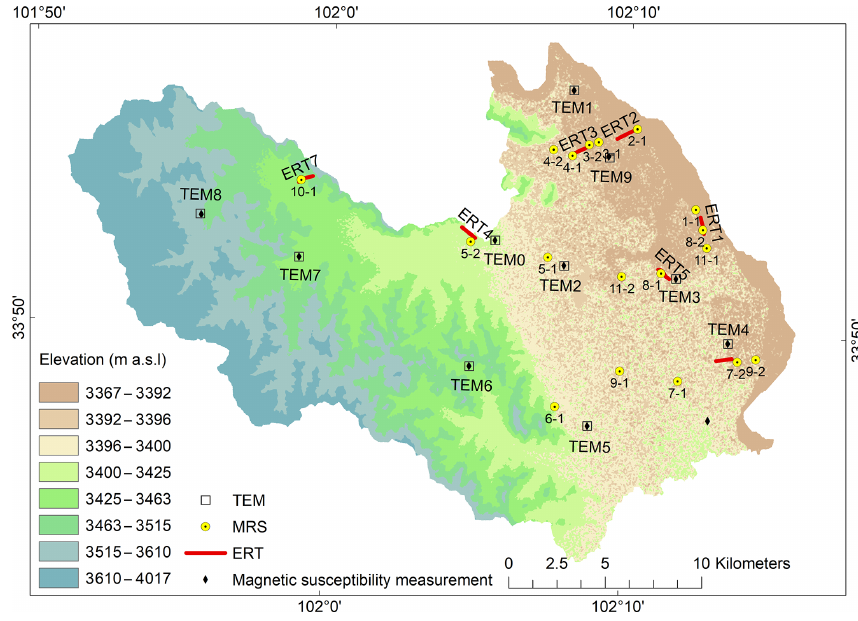
Figure 5. Location of hydrogeophysical surveys. Table 2. Seven DEM